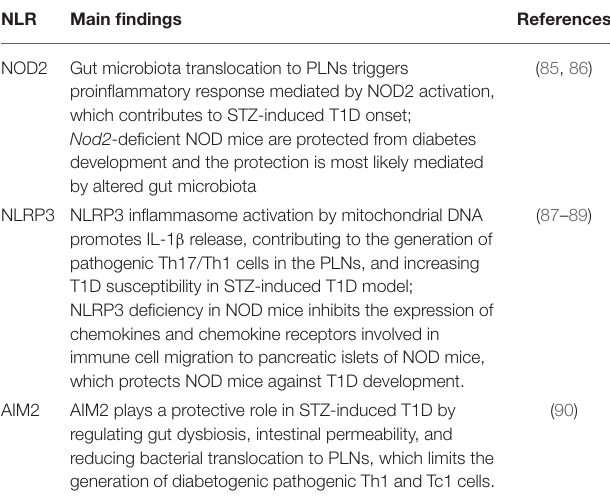
TABLE 1 | Summary of experimental studies about the role of NLRs in T1D. NLR Main